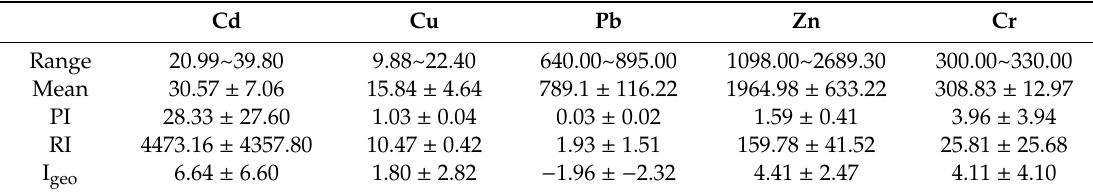
Table 1. Concentrations of heavy metals (mg kg − 1 ) in soil and pollution evaluation.